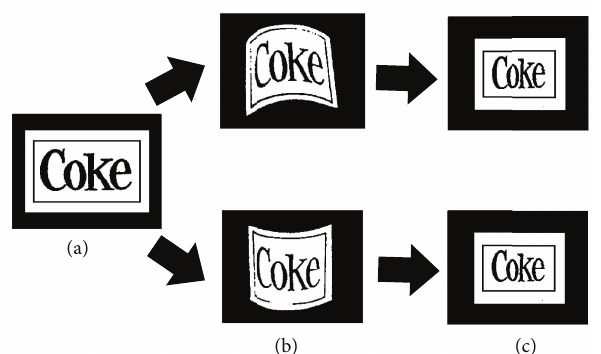
Figure 3: Restoration of image from the biquadratic distortion by inverse